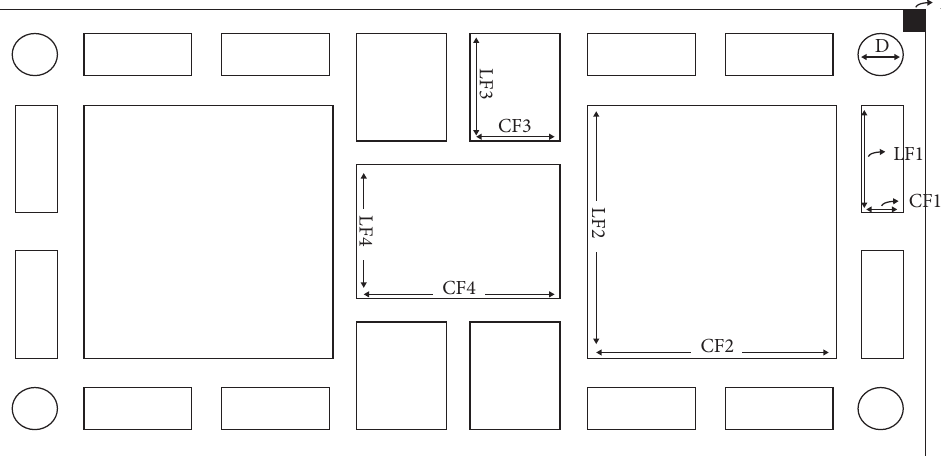
Figure 4: Sketch of the ceramic brick used highlighting the point used for temperature measurement. Table 1: Values used in numerical simulations with a ceramic brick (geometrical data).